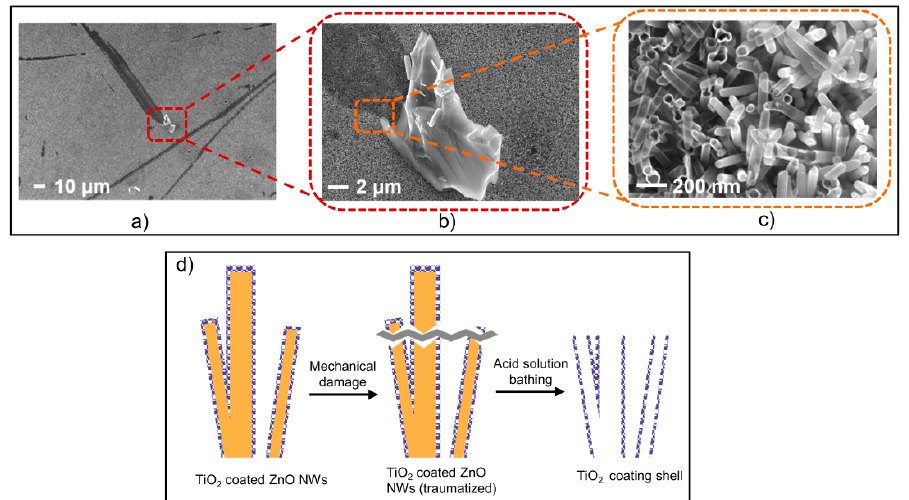
Figure 3. ( a – c ) Zoomed SEM views of 10 nm ALD TiO 2 coating on ZnO NWs after bathing in pH 3 aqueous solution for 30 min. ( d ) A schematic of the protective effect of the TiO 2 coating.